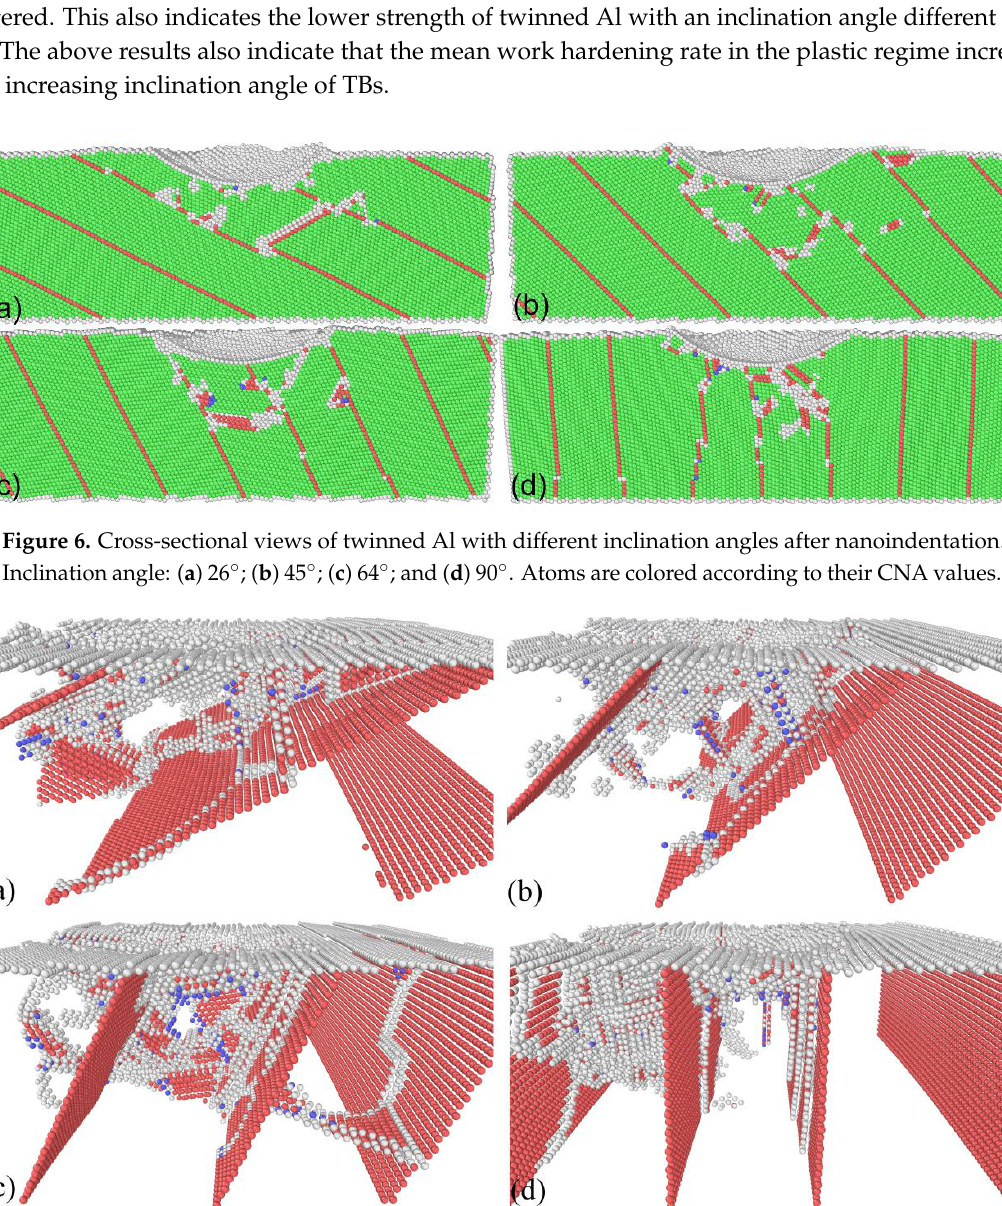
Figure 8. Surface morphology of twinned Al with different inclination angles. Inclination angle: ( a )0°; ( b ) 26°; ( c ) 45 o ; ( d )64°; and ( e ) 90°. Atoms are colored according to their atomic heights. 4. Conclusions In summary, we performed MD simulations to investigate the fundamental deformation mechanisms of nanotwinned Al containing inclined TBs under spherical nanoindentation. It was found that the plastic deformation of nanotwinned Al is dominated by individual deformation modes of dislocation slip, dislocation–TB interaction, and TB migration, the interaction between which is strongly dependent on the inclination angle of TBs with respect to the indented surface. The mean work hardening rate in the plastic regime increases with increasing inclination angle of TBs. Specifically, for an inclination angle of 45°, the critical force and displacement for the elastic–plastic transition are the highest, and the surface pile-up morphology is the most pronounced. Author Contributions: Y.L., Y.D. and J.Z. conceived the project, Y.L. and J.Z. performed the simulations, Y.D. and J.Z. wrote the manuscript.